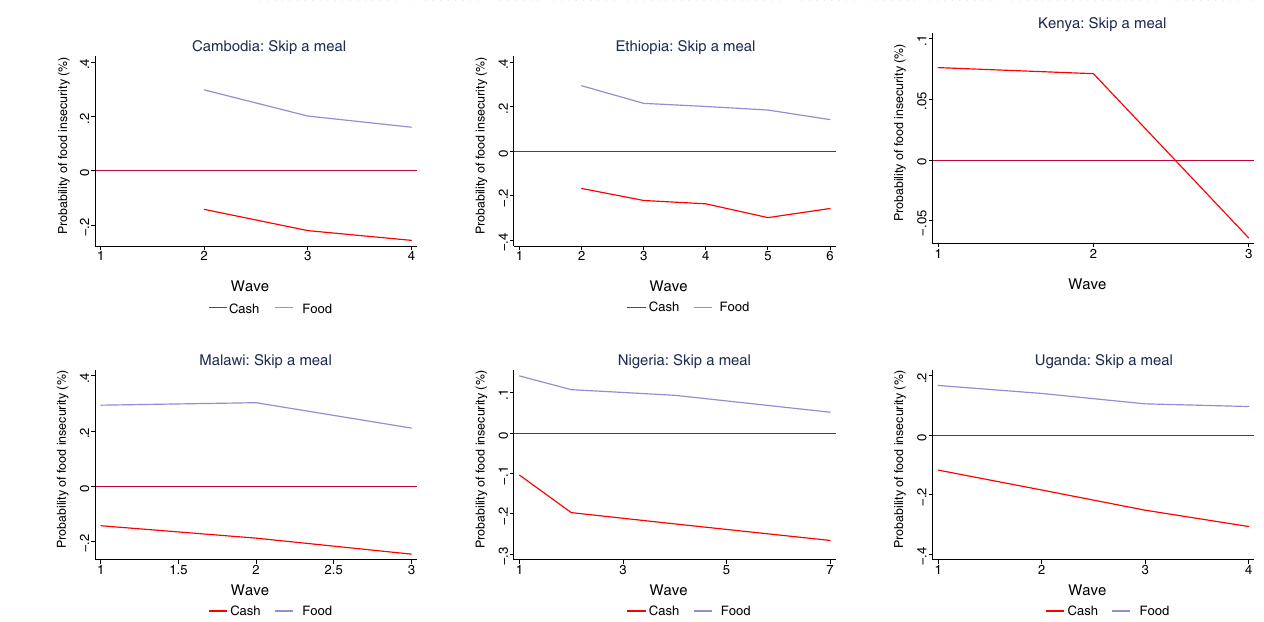
Figure 5. Impact of safety nets on food insecurity (skipped a meal) by